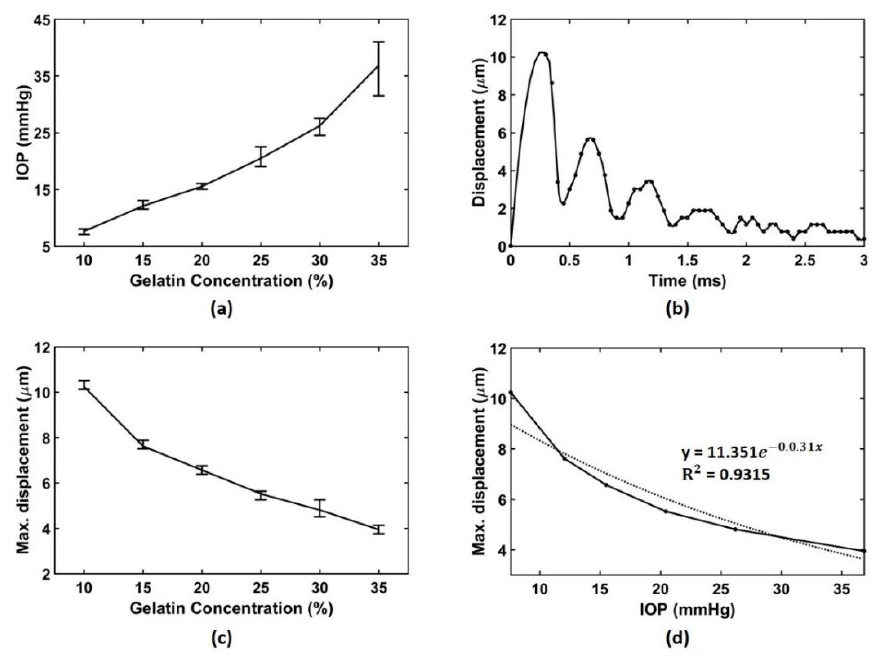
Figure 7. ( a ) Measured IOP values using the rebound tonometer, ten data sets were obtained, ( b ) measured displacement over time in a 10% gelatin phantom, real data (black dot) were interpolated by quadratic spline interpolation method (solid line), ( c ) average of the maximum displacement for each gelatin phantom, measurement was repeated ten times from each phantom, and ( d ) relationship between average of the maximum displacement measured by acoustic radiation force and IOP obtained by the rebound tonometry. Table 4. Measured displacement induced by the acoustic radiation